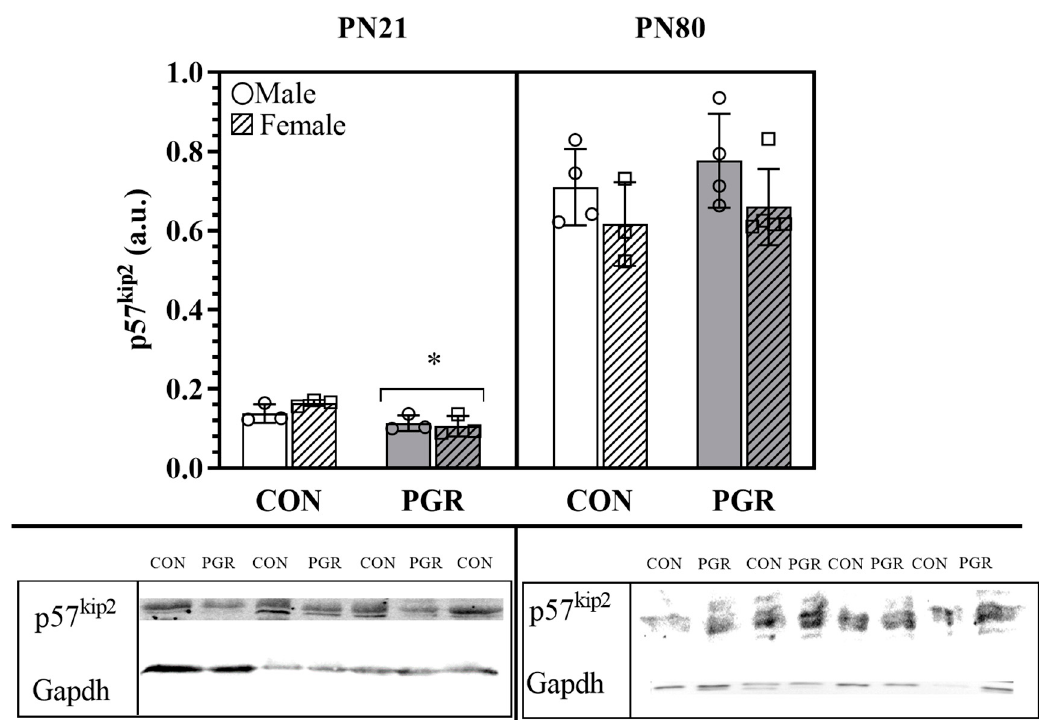
Figure 3. Western blotting protein abundance of p57 kip2 : PN21; p57 kip2 PGR ( n = 6) abundance was significantly less than for CON ( n = 6); (*; p = 0.007). At PN80, no significant differences were seen, as abundance is recovered ( p > 0.05; CON: n = 7, PGR: n = 9). Values are mean ± SD. The blots below the bar graphs are contiguous, representative bands selected from the gels.